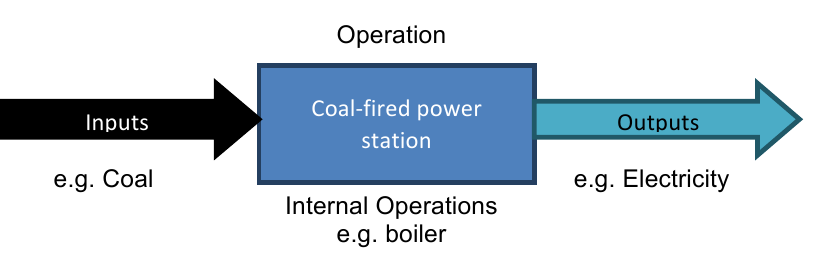
Figure 2. Input-operation-output diagram for the risk assessment.